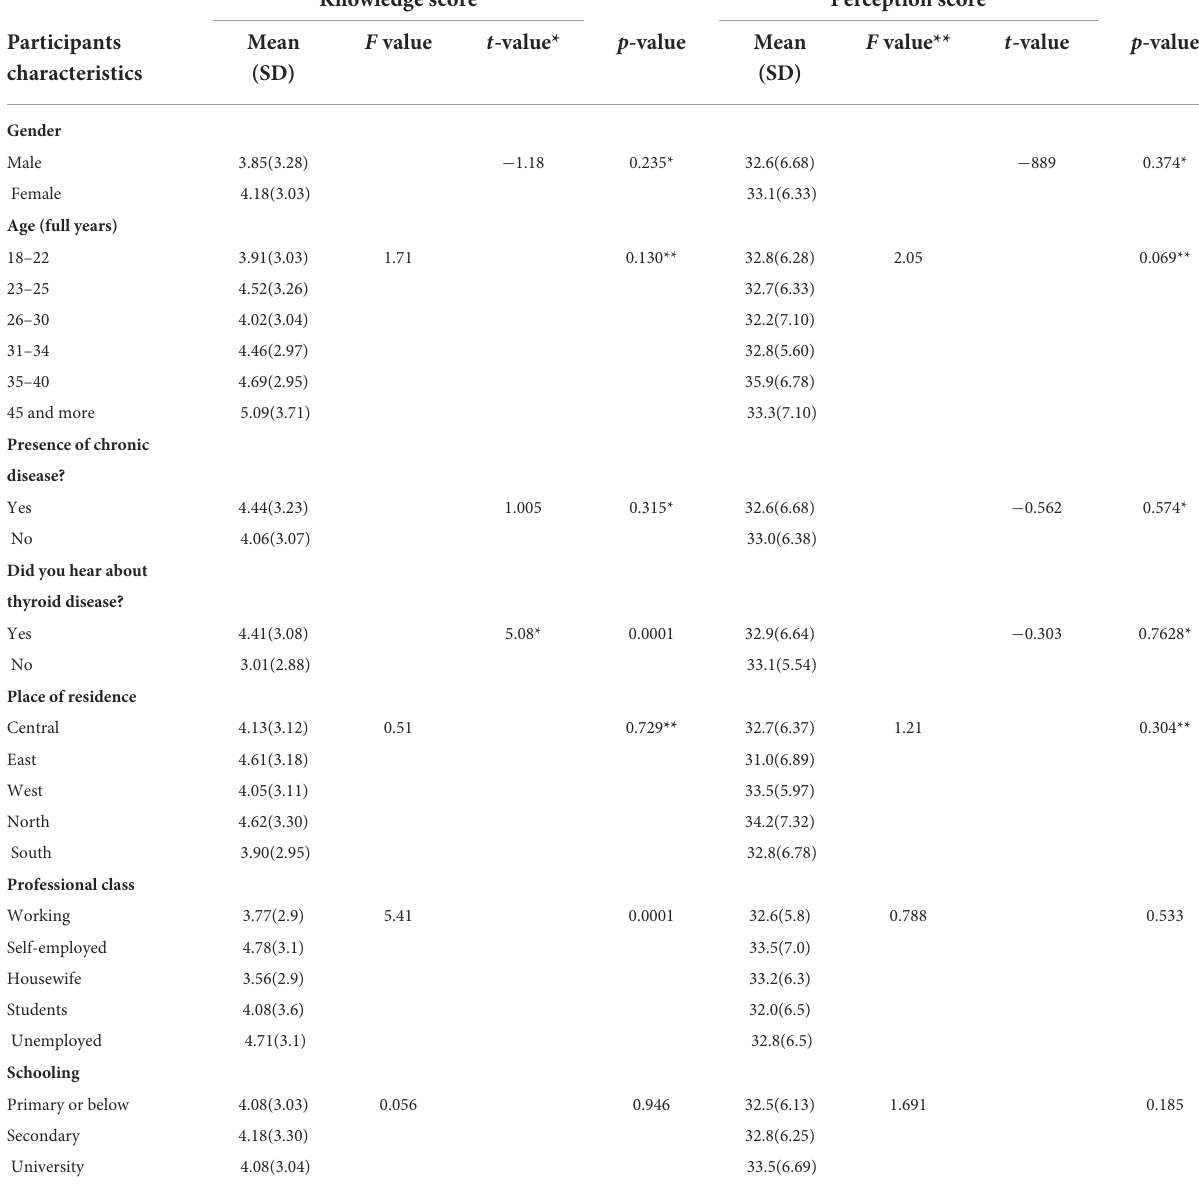
TABLE 5 Differences between knowledge and perception scores and participant